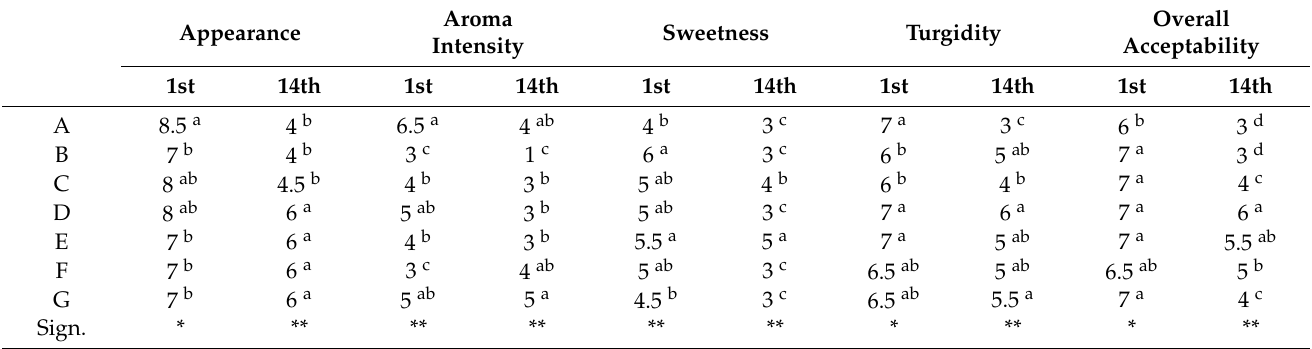
Table 6. Sensorial characterization of minimally treated